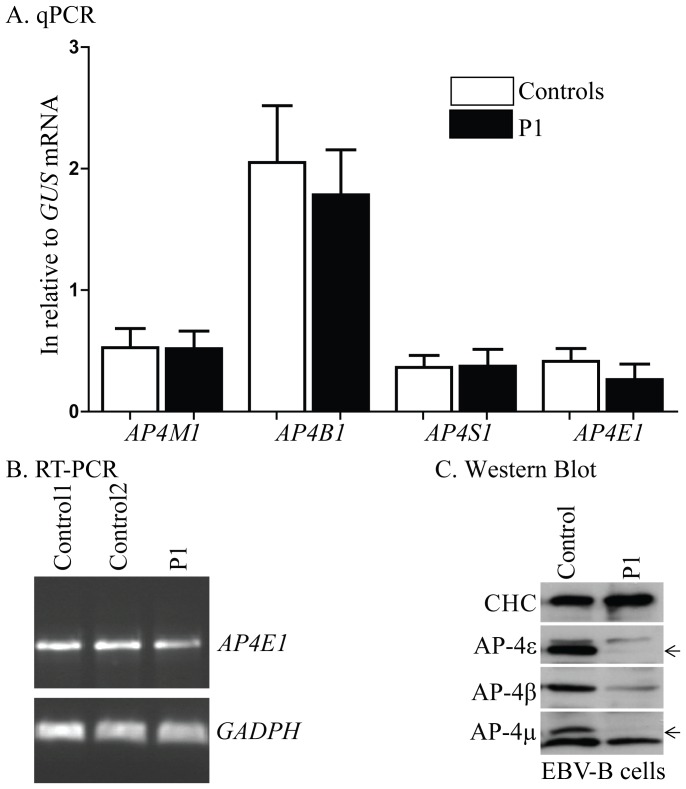
mRNA and protein levels for the subunits of the AP-4 complex.A). RT-qPCR to assess mRNA levels for the components of the AP-4 complex in EBV-B cells from P1. B). RT-PCR to assess the splicing of AP4E1 mRNA. C). Western blot: whole-cell homogenates from EBV-B cells from P1 and a healthy control were subjected to western blotting for clathrin heavy chain (CHC; loading control), AP-4ε, AP-4β or AP-4 μ. The loss of AP-4ε results in a concomitant decrease in the levels of AP-4β and AP-4 μ (specific bands are indicated by an arrow). These experiments were carried out at least twice.